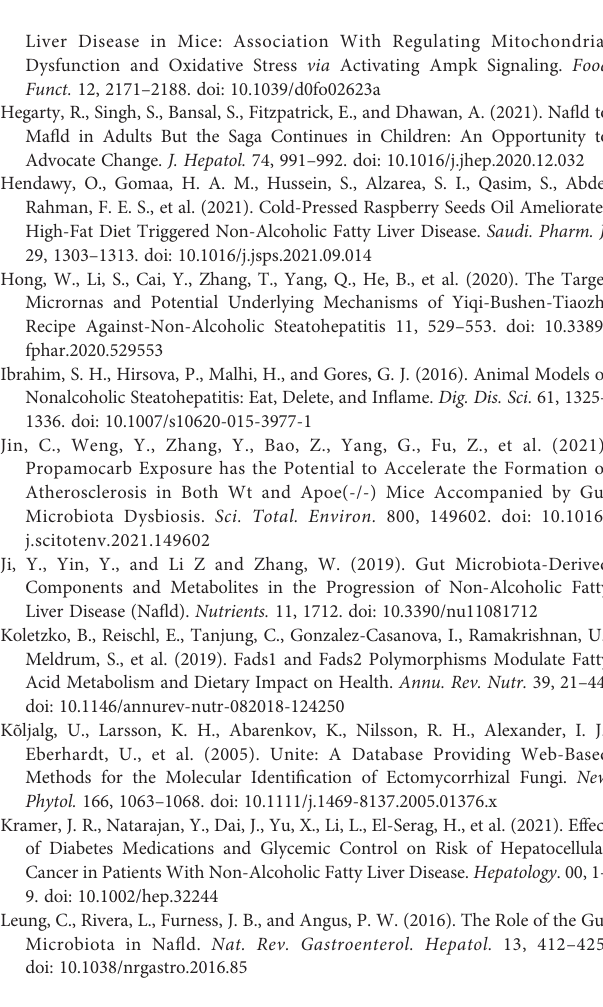
Supplementary Figure 1 | The evolutionary tree of top 100